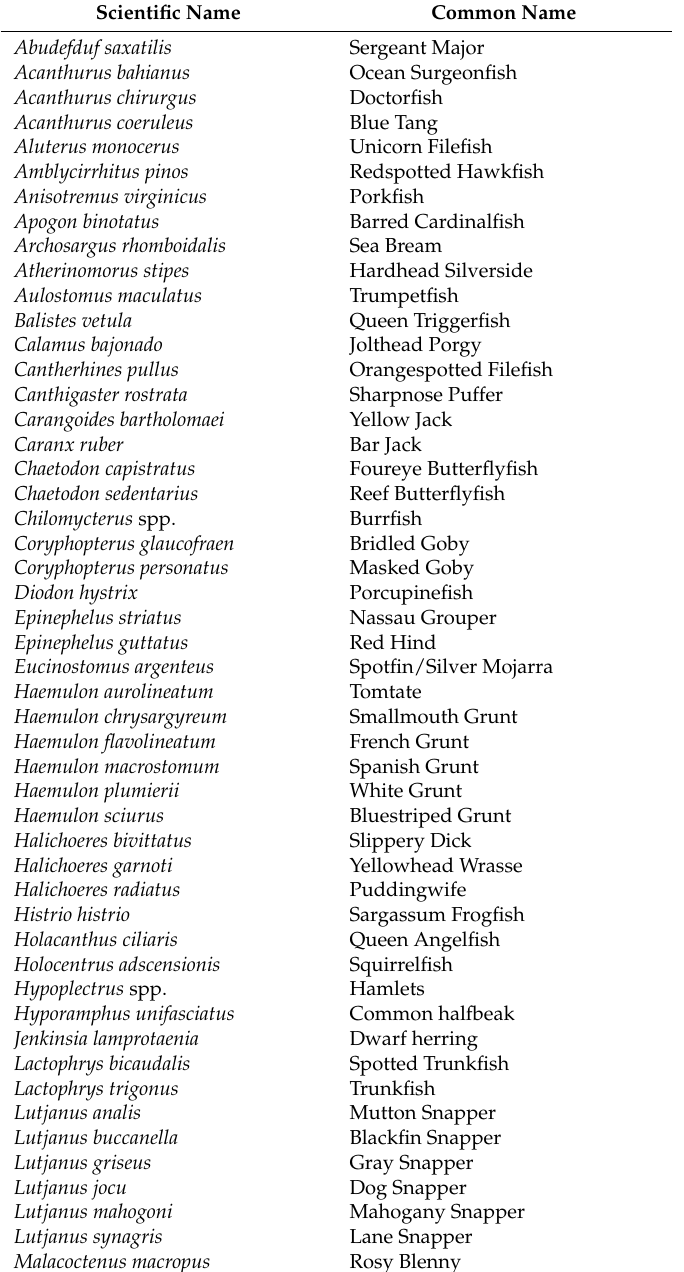
Table 2. Fish species in Hurricane Hole, based on Boulon (1992) [16] with recent additions. Source of names is Fishbase or World Register of Marine